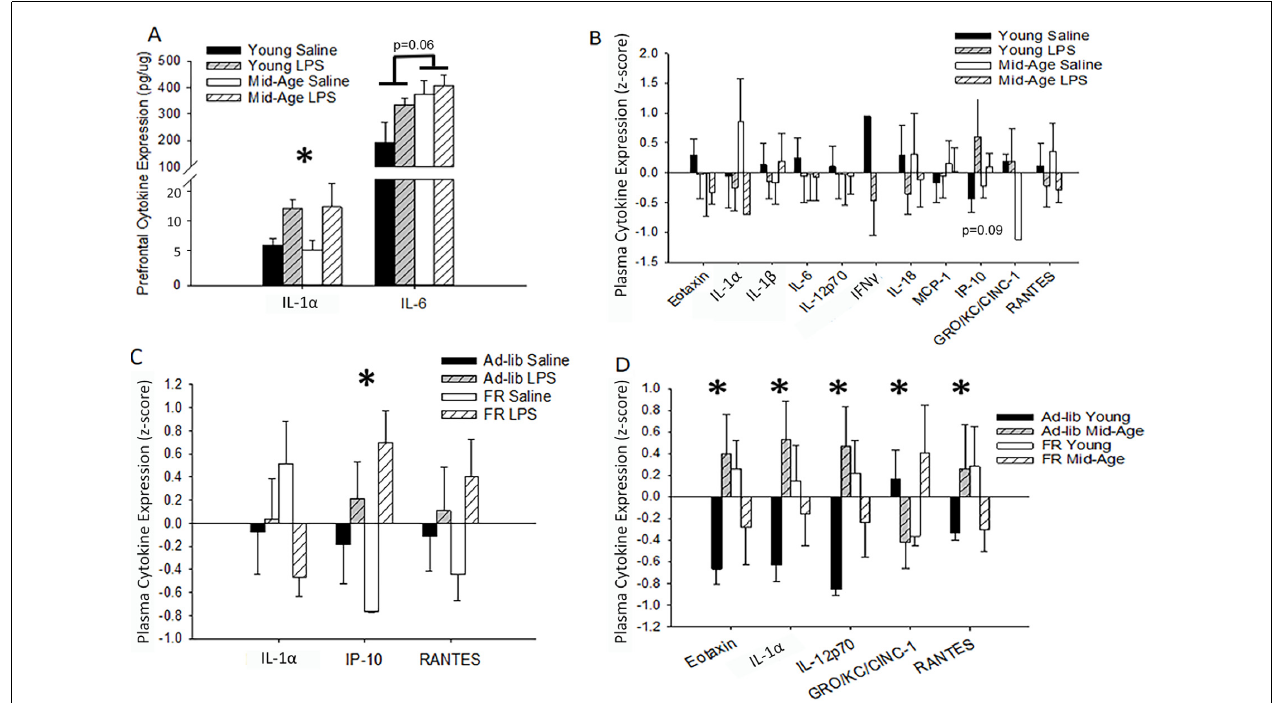
FIGURE 5 | Age, treatment, and food restriction elicit differential effects on brain and plasma cytokine levels. Brain and plasma cytokine levels were assessed for changes in response to systemic inflammation and age. The prefrontal cortex (PFC) of rats chronically treated with LPS exhibited an increase in IL-1 α while IL-6 rose specifically in middle-age rats (A) . Their plasma, however, was unaffected by both age and treatment (B) . Due to the known impact of caloric restriction on inflammation, two cohorts of rats, one food restricted and the other with full access to food, were acutely treated with LPS or saline and compared for altered plasma cytokine levels. Food restriction exacerbated LPS effects for IP-10 (C) . However, food restriction mitigated age-specific increases in multiple cytokines, including eotaxin, IL-1 α , IL-12p70, and RANTES (D) , demonstrating that middle-age rats exhibit heightened levels of pro-inflammatory cytokines and partial caloric restriction attenuates these levels. Data are presented as means ± SEM. ∗ p <